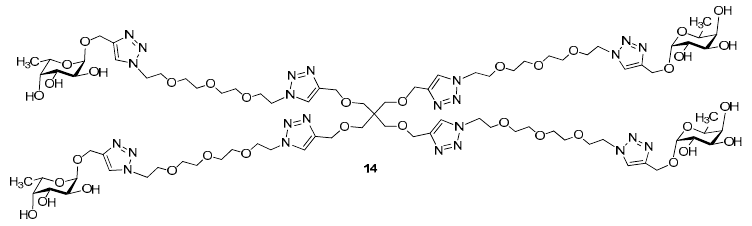
Figure 1. The tetravalent, α - L -fucoside-containing inhibitor with tetraethylene glycol bridges (compound 14 ) [29].